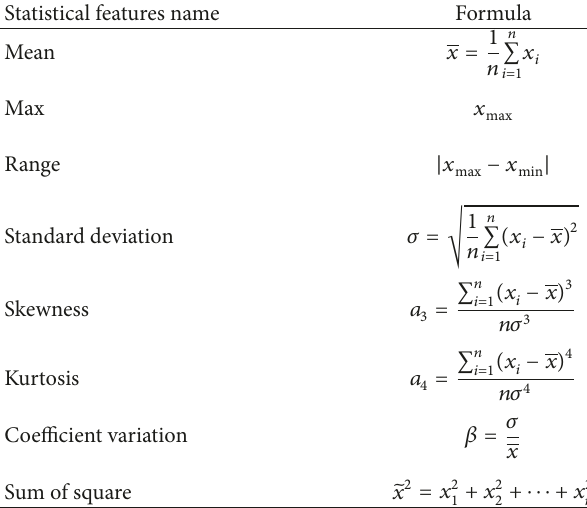
Table 1: Eight statistical features.